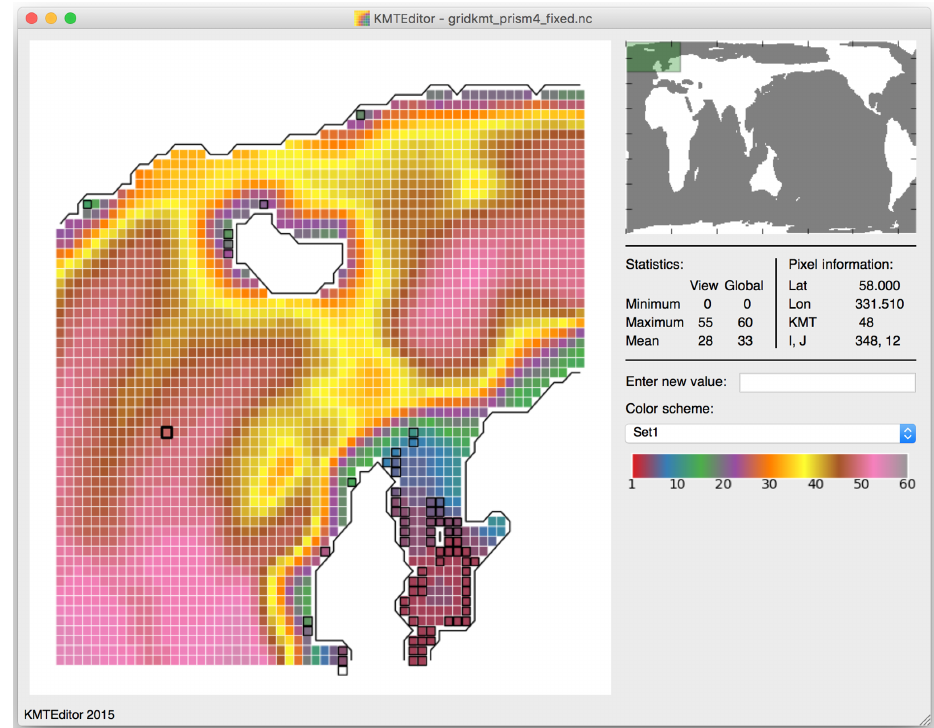
Figure 2. A screenshot of one of our graphical tools for editing the ocean model grid. The dark black square on the left side plot is the cursor, which can be used to navigate to individual cells in order to change their values. The cells outlined by a thin dark border denote cells with values that have been